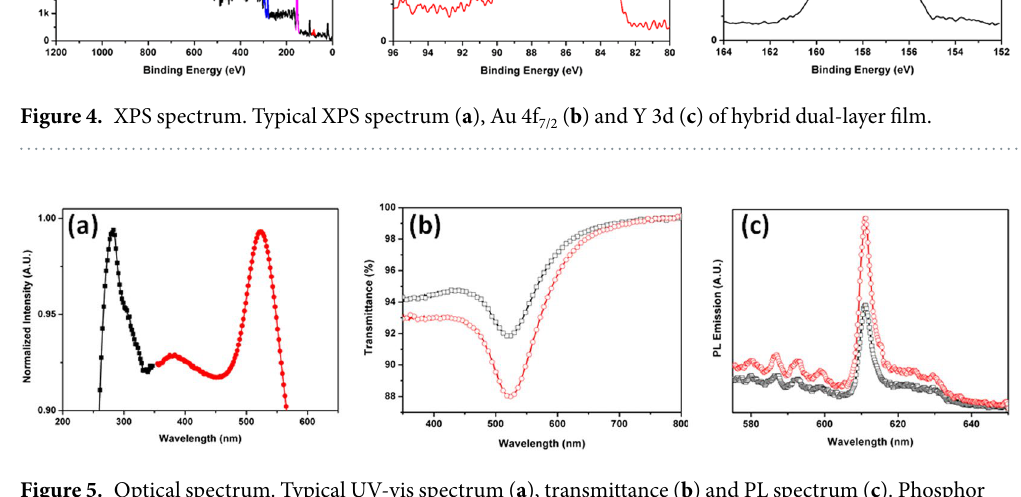
Figure 5. Optical spectrum. Typical UV-vis spectrum ( a ), transmittance ( b ) and PL spectrum ( c ). Phosphor (black) and Au (red) in UV-vis spectrum ( a ). Phosphor monolayer (black) and hybrid dual layer (red) in transmittance ( b ). Phosphor monolayer (black) and hybrid dual layer (red) in PL spectrum ( c